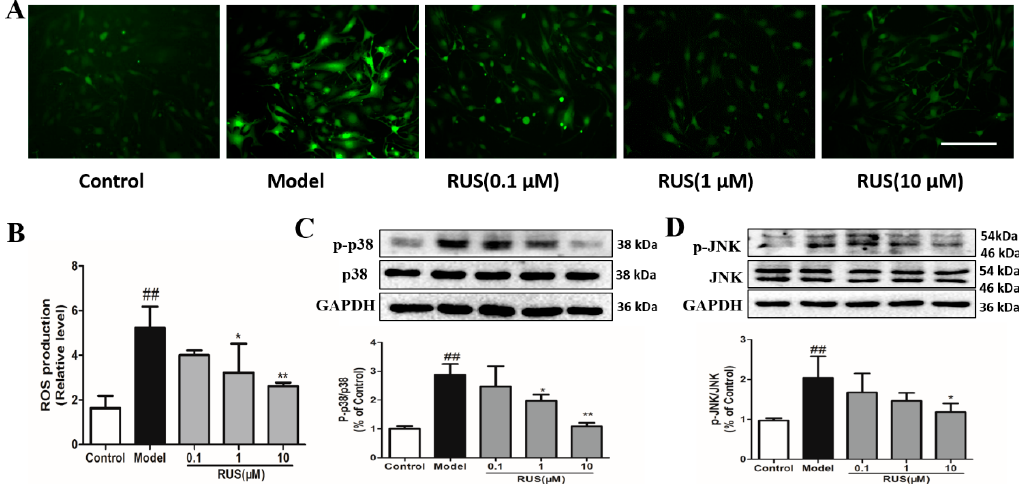
Figure 8. The effects of ruscogenin on ROS generation and the MAPK pathway in bEnd.3 cells after 6 h of OGD and 1h reoxygenation. ( A ) The intracellular ROS was viewed with fluorescence microscopy. Scale bar = 100 µ m; ( B ) the resulting fluorescence intensity was quantified using ImageJ (National Institutes of Health, Bethseda, MD, USA); ( C , D ) representative Western blot bands and quantitative analysis of the ratio of p-p38/p38 and p-JNK/JNK; the band intensities were measured using scanning densitometry. The data were normalized to GAPDH expression ( n = 3). The data are expressed as means ± SD. ## p < 0.01 ν s. Control, * p < 0.05, ** p < 0.01 ν s. Model.